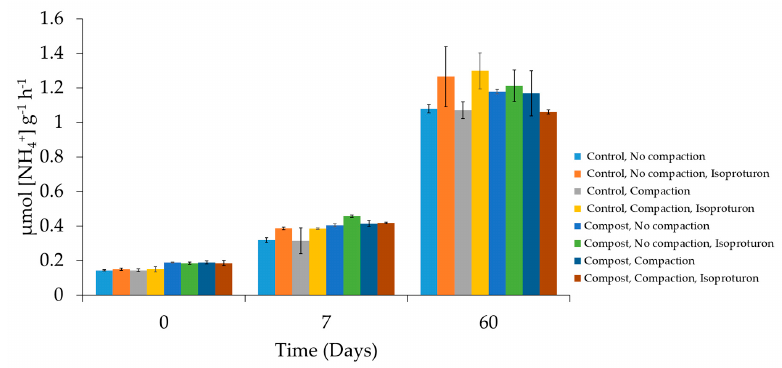
not treated and treated with isoproturon after 0, 7 and 60